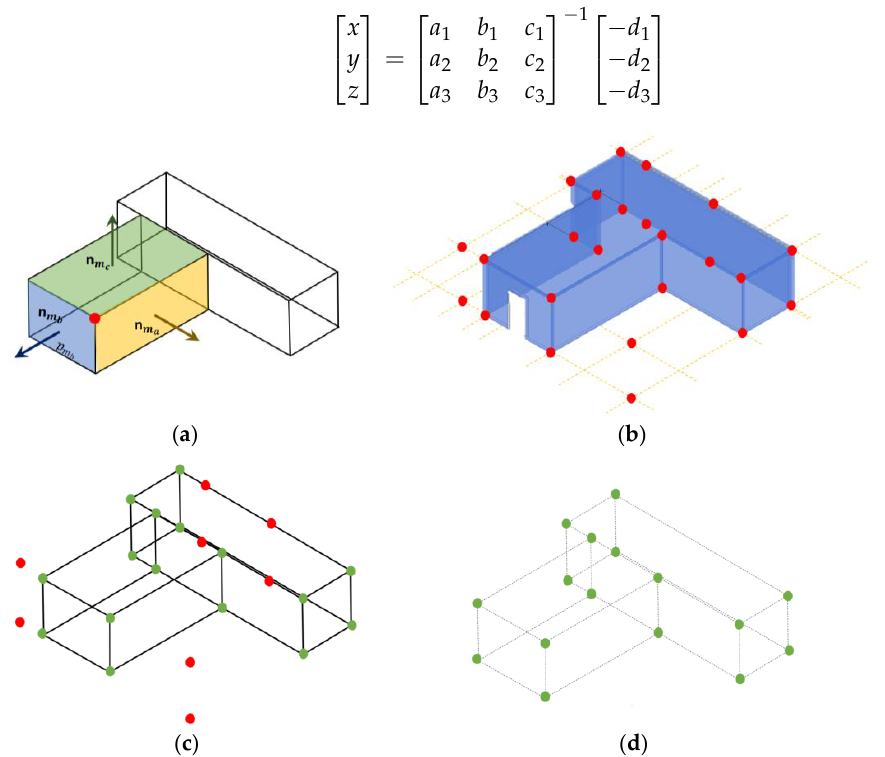
Figure 3 . Visualization of ( a ) a single corner point generated from three parent planes; ( b ) all the possible corner points generated from a model, including the false points; ( c ) differentiation of false corner points (red color) from others (green) after verification; and ( d ) final corner points (green) in the model . Equation (1) generates the intersection points for the given plane segments based on